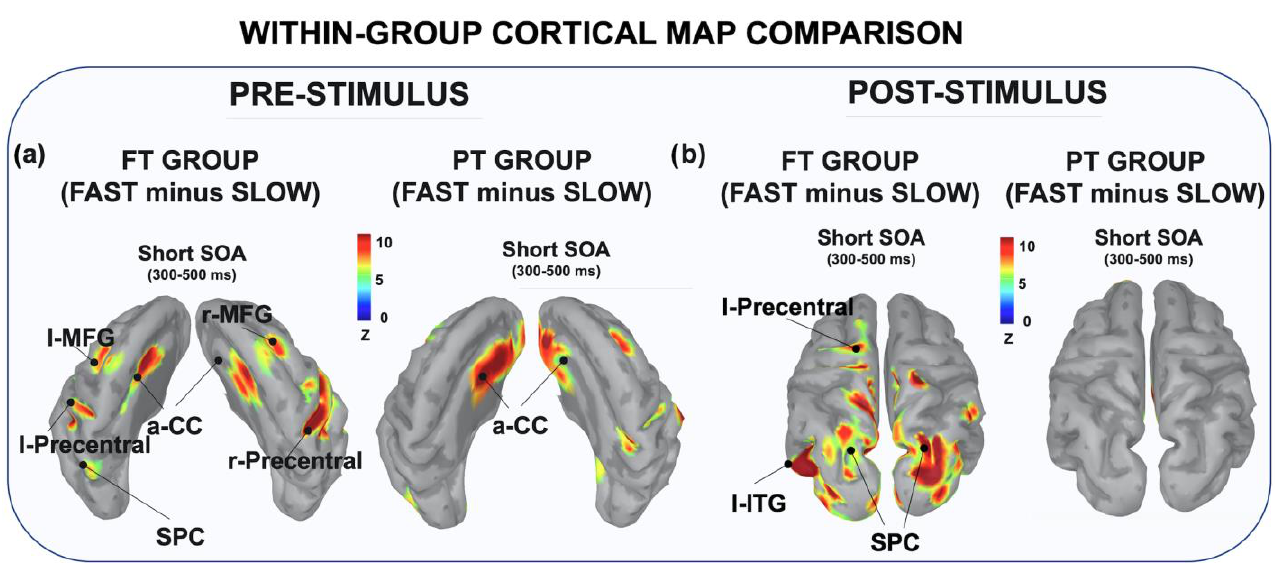
Figure 7. Within-group differential cortical map reconstruction. The pictures display the differential (fast minus slow blocks) cortical map reconstruction relative to each significant ERP effect for pre- stimulus ( a ) and post-stimulus ( b ) temporal windows. Data were adjusted using a threshold of 50% of the maximum amplitude and a size of at least 10 vertices and they were reported on a template cortex smoothed at 40%.